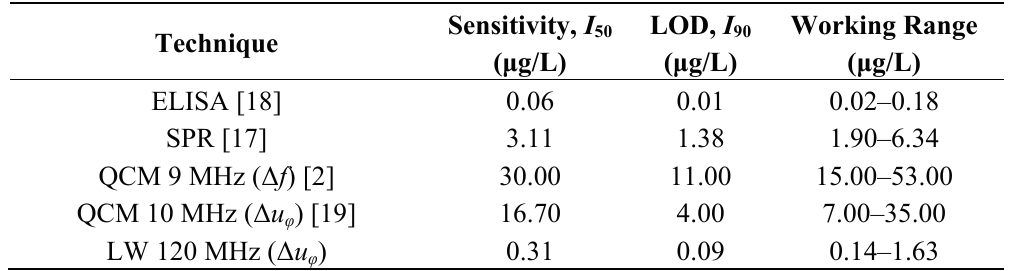
Table 2. Analytical parameters of carbaryl determination based on ELISA, SPR, Quartz Crystal Microbalance (QCM) and the developed Love Wave (LW) immunosensor. Δ f means that the measurement were carried out using an oscillator electronic configuration, and Δ u means that the measurement were carried out using the described φ phase and amplitude detection at fixed